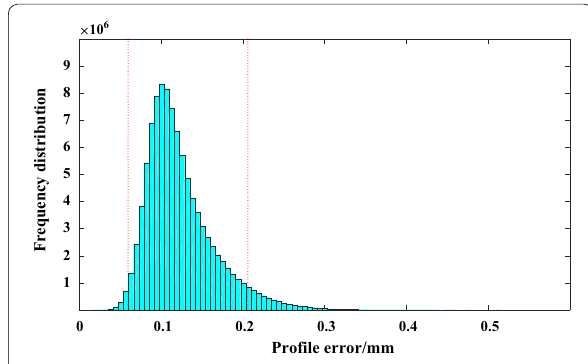
Figure 8 Frequency distribution of profile error in AMCM